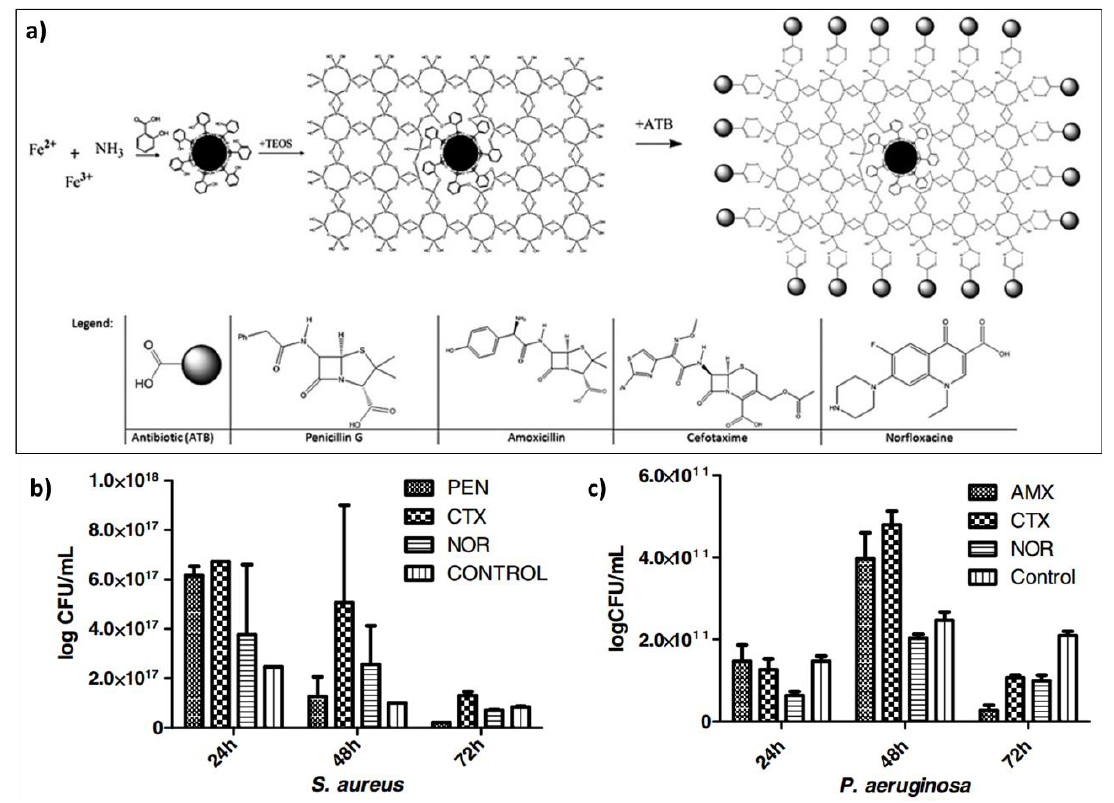
Figure 8. ( a ) Synthesis of Fe 3 O 4 / SA / SiO 2 / ATB nanoparticles. The gray sphere represents the antibiotic (ATB) molecule. The comparative representation of the viable cell counts recovered from the ( b ) S. aureus biofilms and ( c ) P. aeruginosa developed on MAPLE-deposited thin films at 400 mJ cm − 2 . (Reproduced with permission from [116]. IOP Publishing, 2012).